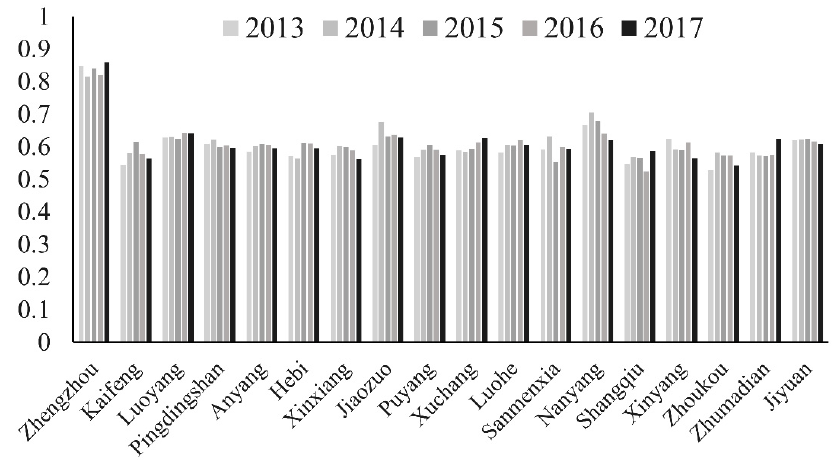
Figure 3. Evolution of the coupling degree of regional infrastructure construction and economic development level.